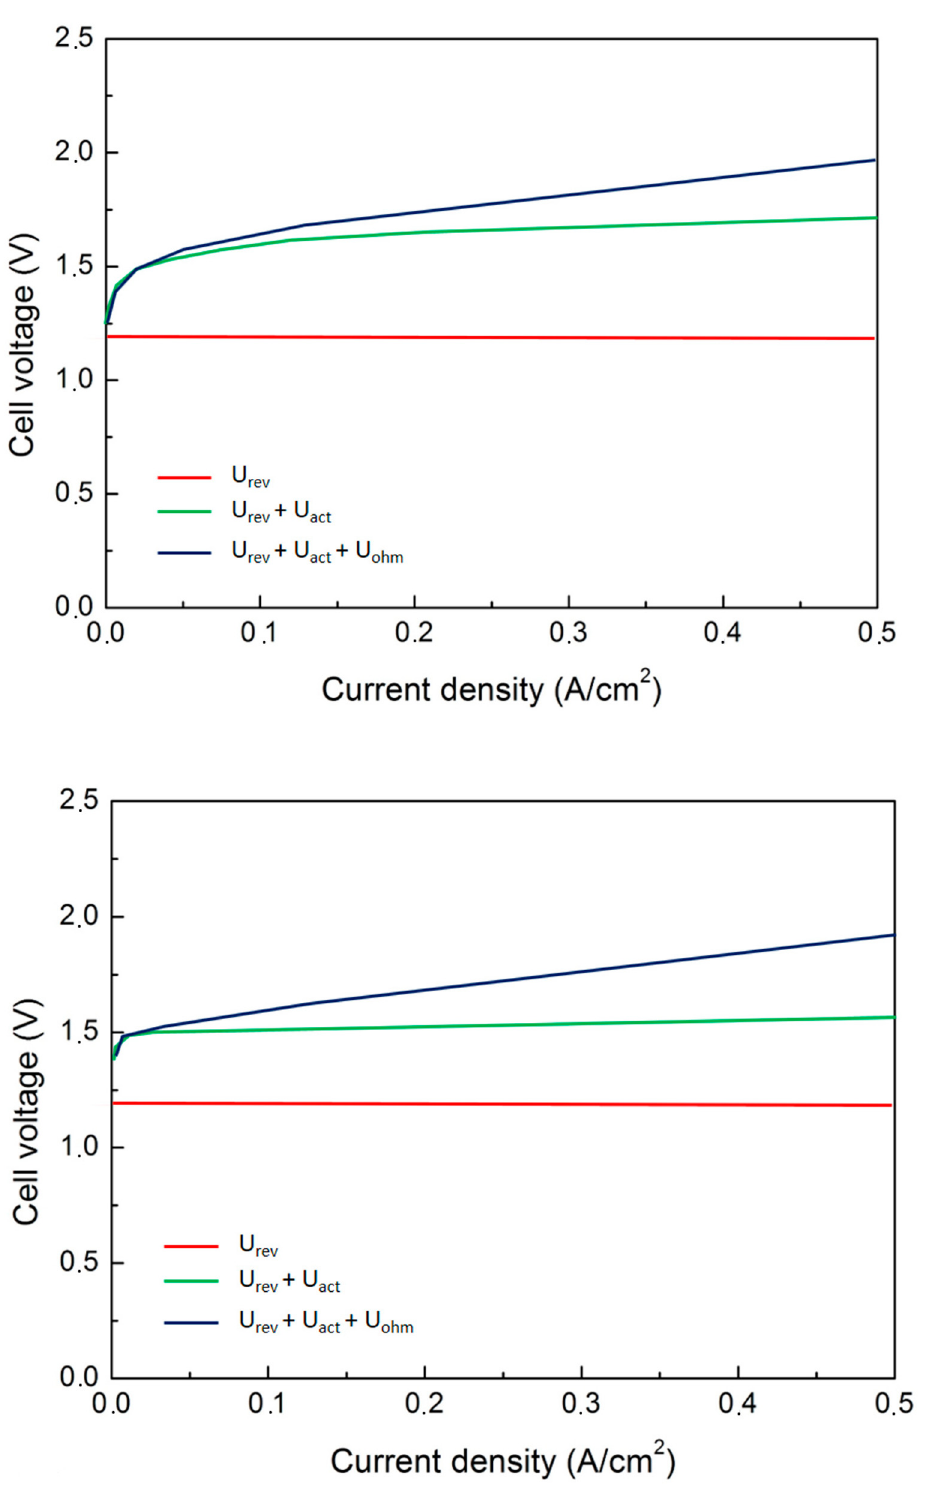
Figure 7. Overpotentials in AEL and PEMEL